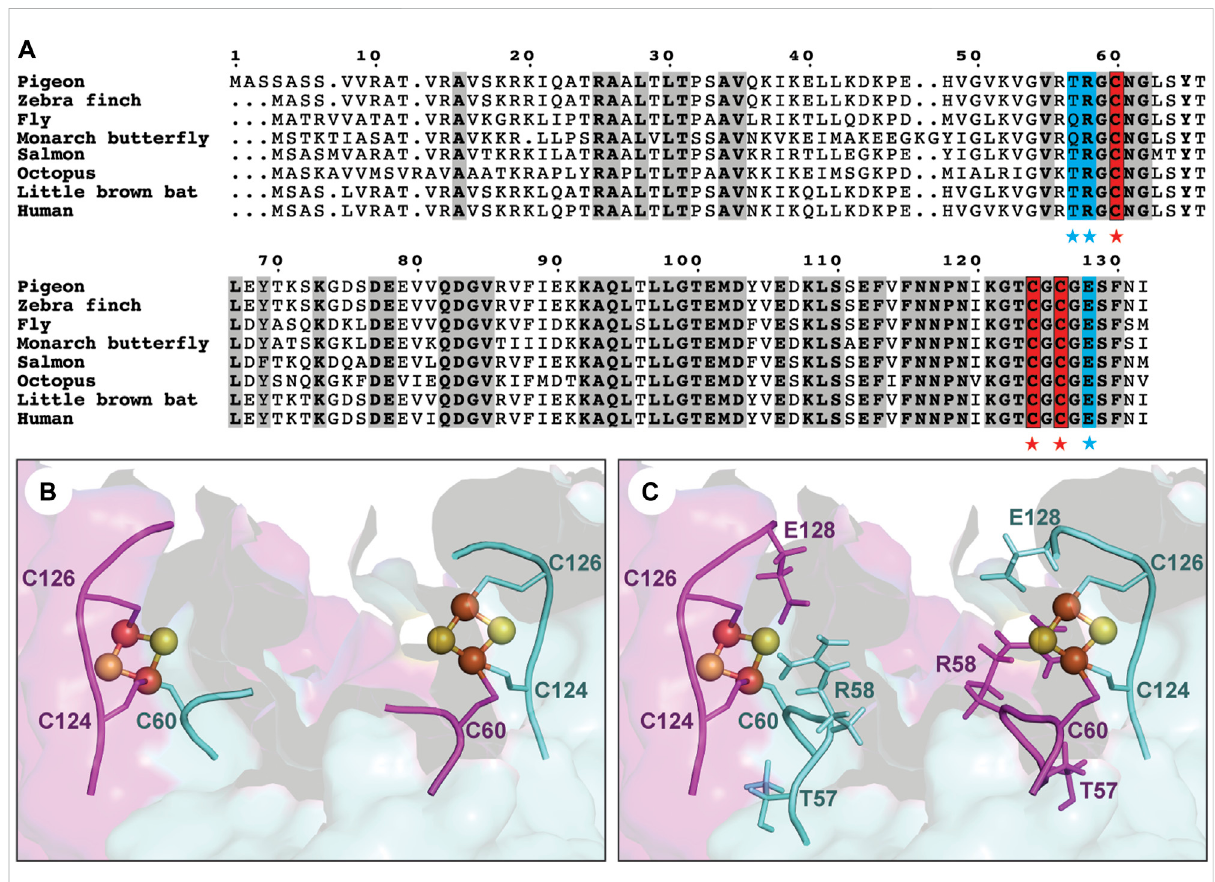
FIGURE 1 Sequence conservation and structural feature of the iron-sulfur cluster binding site of clMagR. (A) Sequence alignment of MagR from eight representative species. Three conserved cysteines (C60, C124 and C126) forming the iron-sulfur cluster binding site are highlighted in red background and marked by red stars. Residues are mutated in this study are shown in blue background and marked by blue stars. The conserved residues are shown in bold and grey background. (B) Six conserved cysteines from clMagR dimer form two iron-sulfur cluster binding sites in structural model. (C) Three nearby residues (T57, R58 and E128) located in twohotspot regions could potentially coordinate with iron-sulfur binding sites are shown in structural